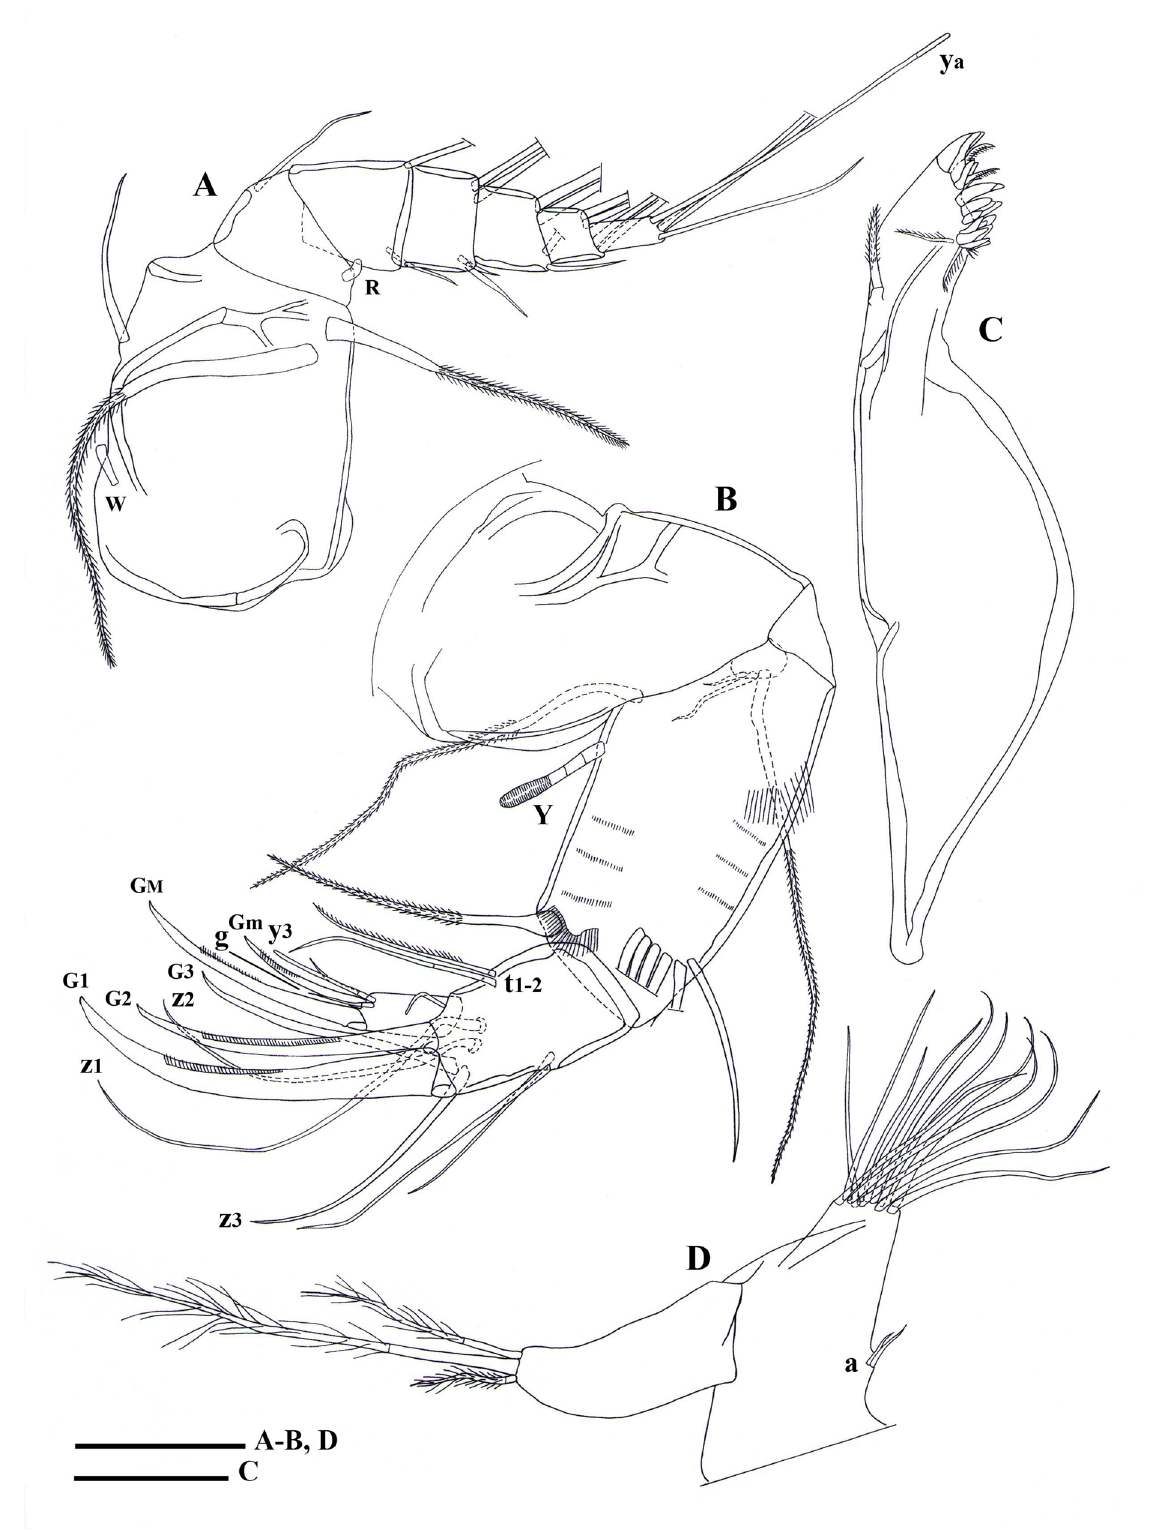
Fig. 9. Siamopsis conspecta gen. et sp. nov., ♀ (MSU-ZOC.201). A . A1. B . A2. C . Md coxa. D .T1. Scale bars: 50